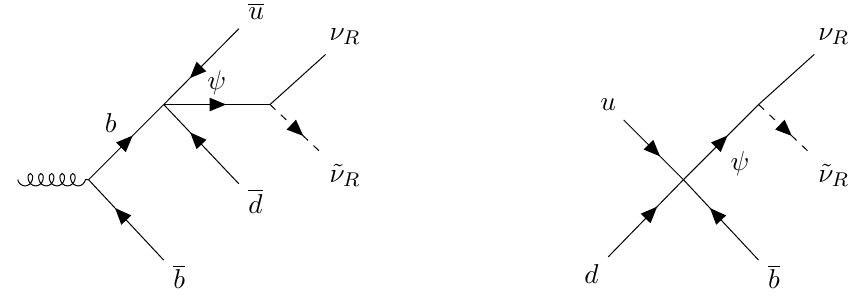
Figure 5. Production channels of the bino at the LHC, also showing its decay into a neu- trino/sneutrino pair. The left diagram schematically shows the decay of a b quark in a b (cid:22) b pair through the e(cid:11)ective four-fermion operator u d b (this is a parton level diagram, the b quark would hadronize before decaying). The right one corresponds to direct production of the bino through the same e(cid:11)ective four-fermion operator. Propagator arrows indicate the (cid:13)ow of baryon